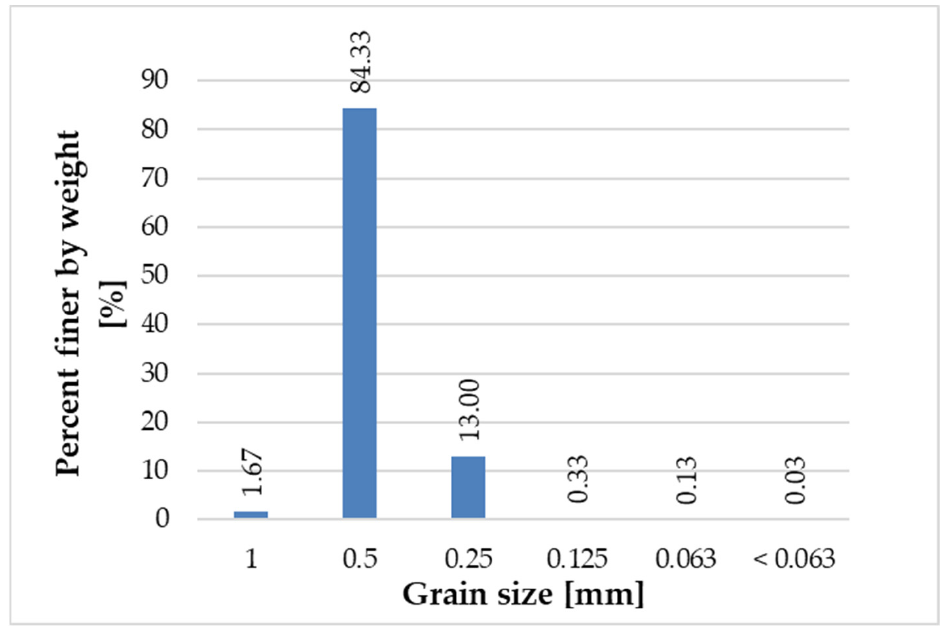
Figure 6. Grain size representation of recycled glass fraction 0.5/1 mm.